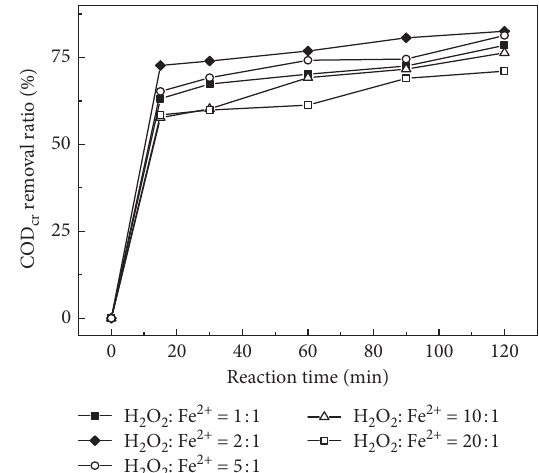
Figure 9: Effect of molar ratio of H